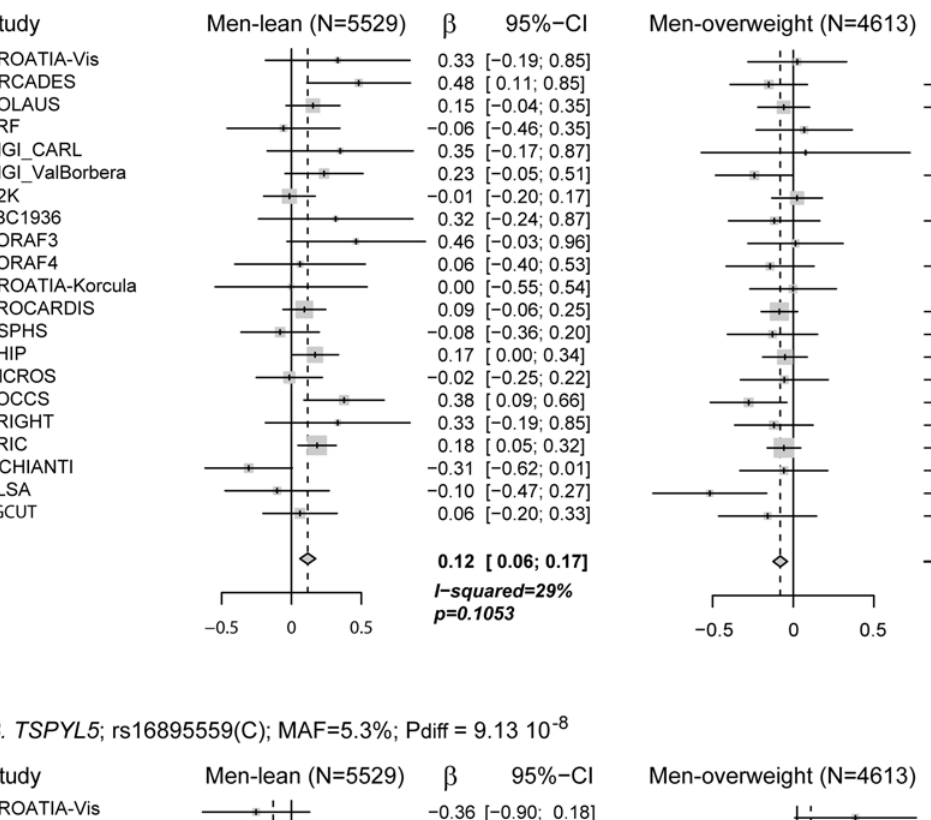
Fig 2. Forest plots of effect sizes within BMI stratum for variants with the two most significant mean effect size differences between BMI stratum. A. RBMS1 - TANK locus and B. TSPYL5 locus. The overall inverse — variance-weighted mean effect per BMI stratum is calculated assuming fixed effect across studies and represented by a lozenge, associated P-value displayed as P. Measure of heterogeneity between studies is reported (I-squared) with associated P-value for significance (p). P diff is the test of difference in mean-effect size P-value. For study abbreviations and references, see S1 Table.